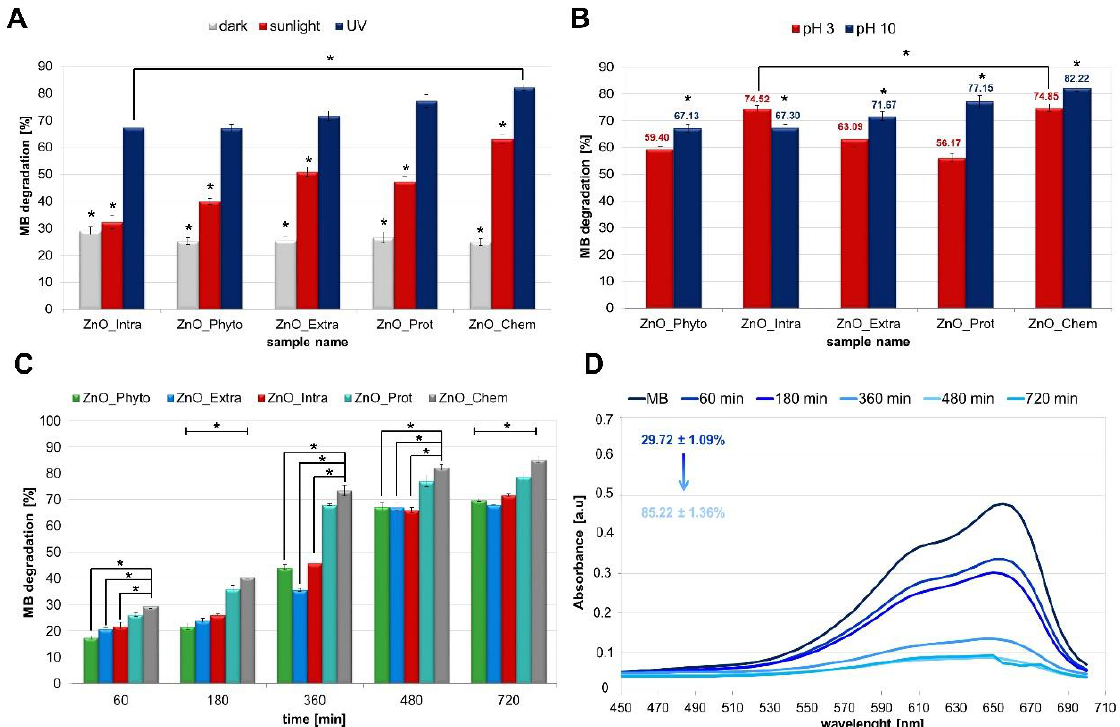
Figure 2. Photocatalytic activity of bare and functionalized ZnO NPs toward methylene blue (MB). The efficiency of MB photocatalytic degradation (%) ( A ) in different light conditions (dark, sunlight and UV irradiation), and ( B ) for different pH values (pH 3 and 10); ( C ) MB degradation time-dependency at pH 10 under UV irradiation; ( D ) UV-vis plot of MB in the presence of ZnO_Chem at pH 10 under UV irradiation. All ZnO NPs were at 1000 μ g/mL concentration. The values are expressed as mean ± SD values of three independent experiments ( n = 3); * p < 0.001 compared to bare ZnO NPs (ANOVA).